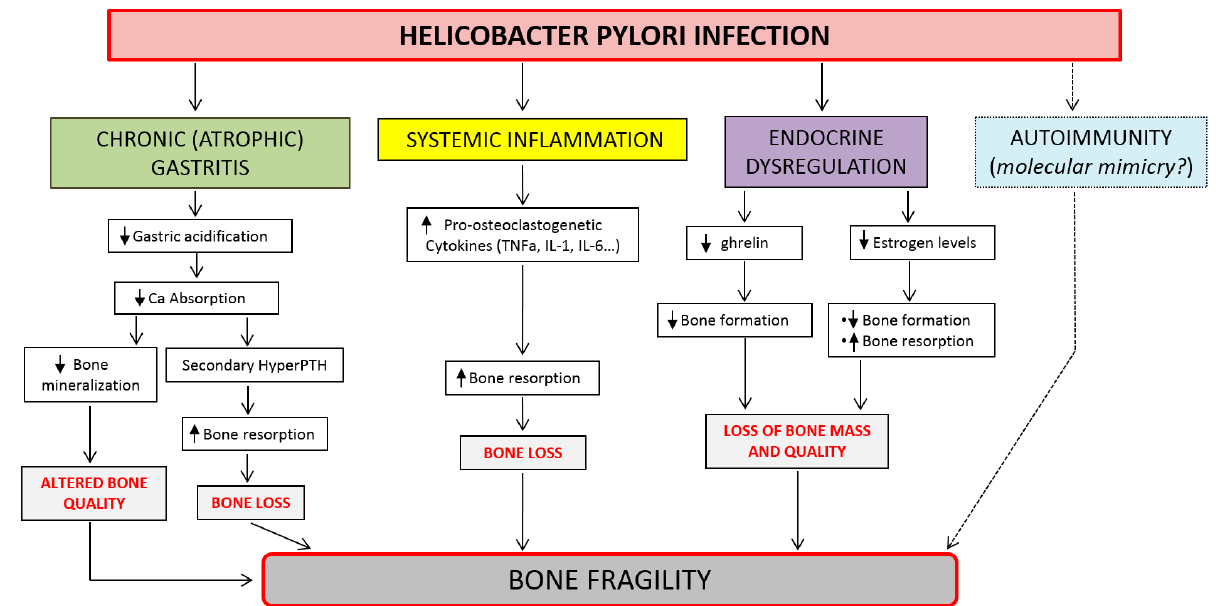
Figure 4. Pathophysiology of bone fragility induced by Helicobacter Pylori infection.